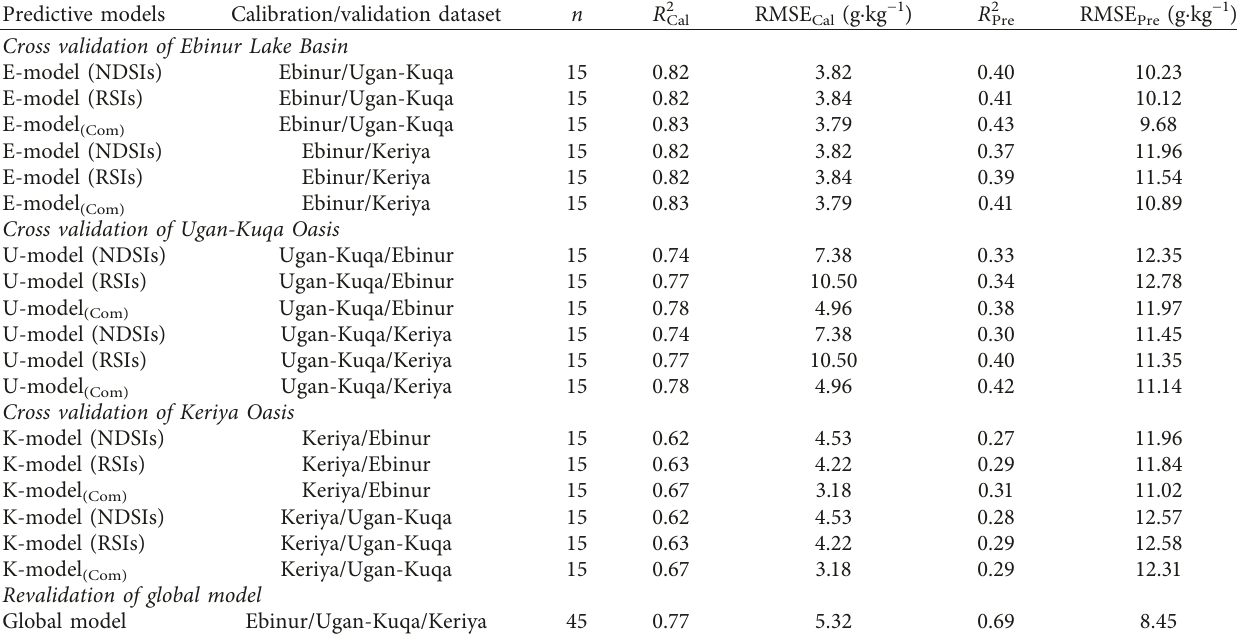
Table 5: Accuracy of cross-validation